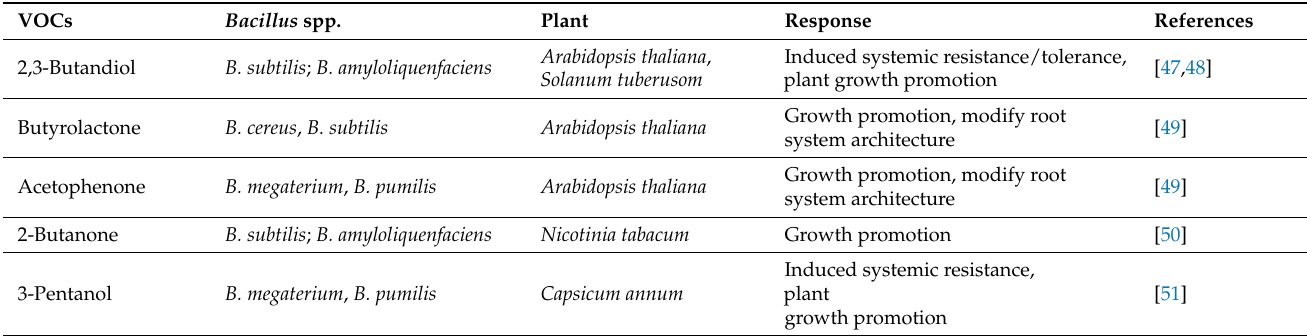
Table 2. Effects of VOCs produced by Bacillus